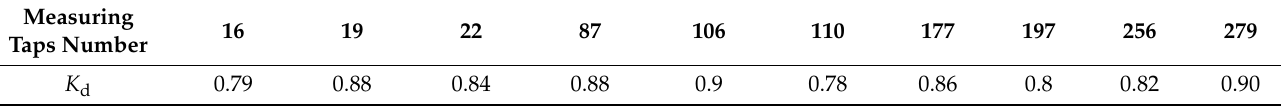
Table 3. Directionality factor K d of different measuring taps for known building orientation. Measuring Taps Number